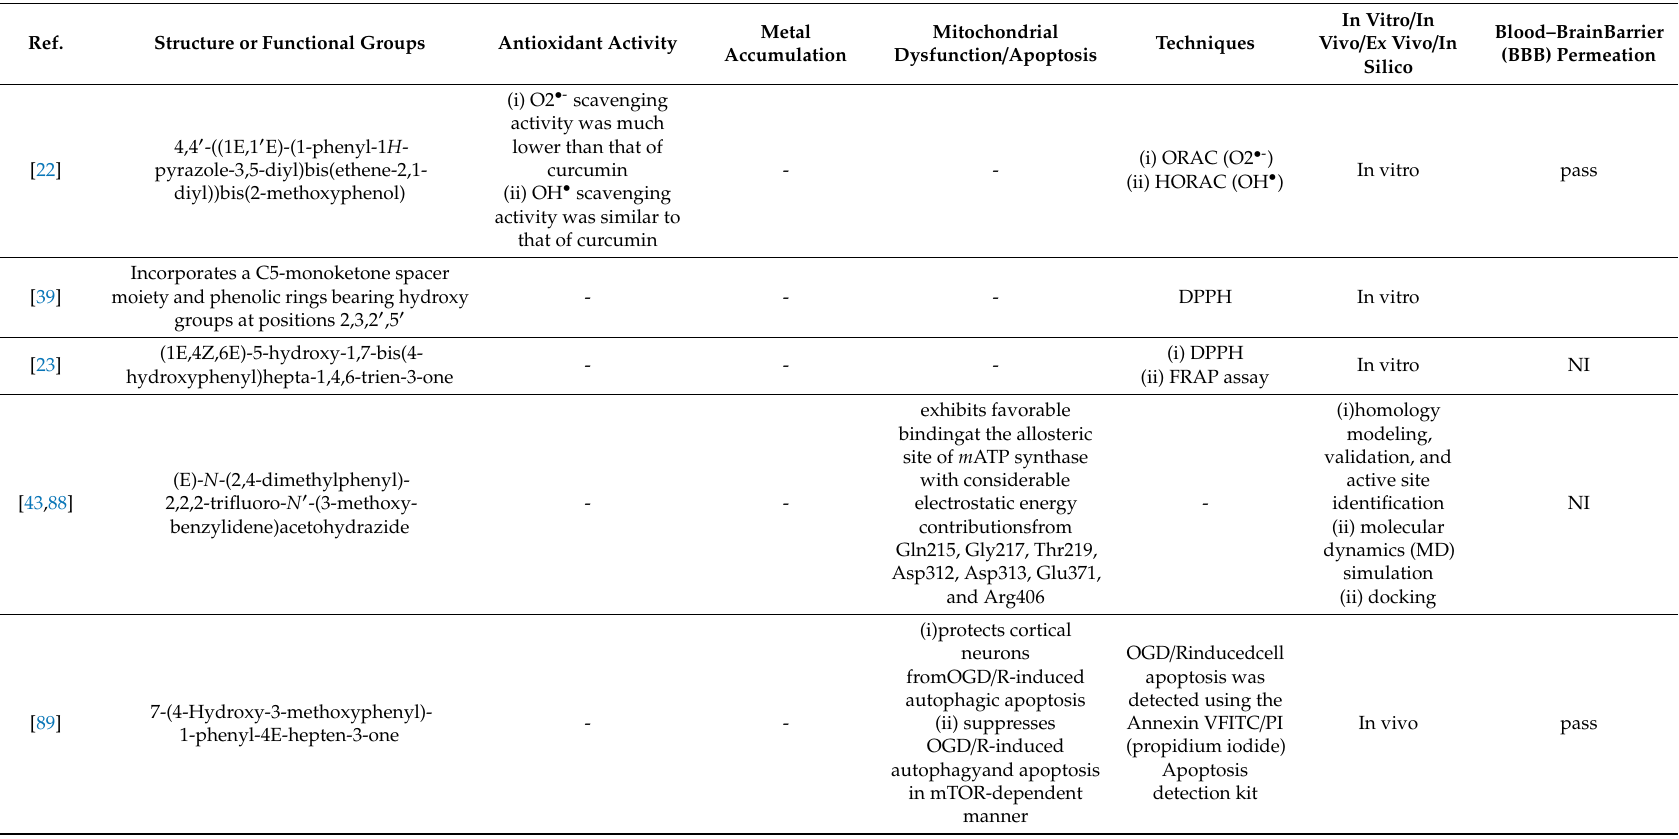
Ref. Structure or Functional